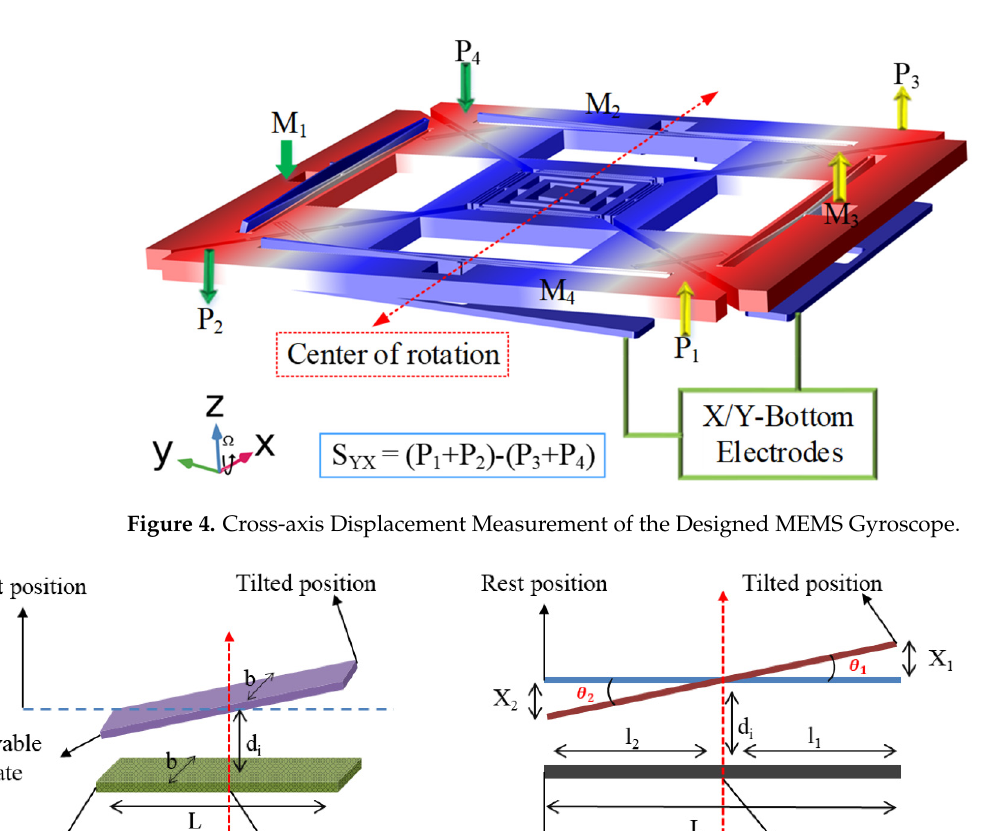
Figure 4. Cross-axis Displacement Measurement of the Designed MEMS Gyroscope.